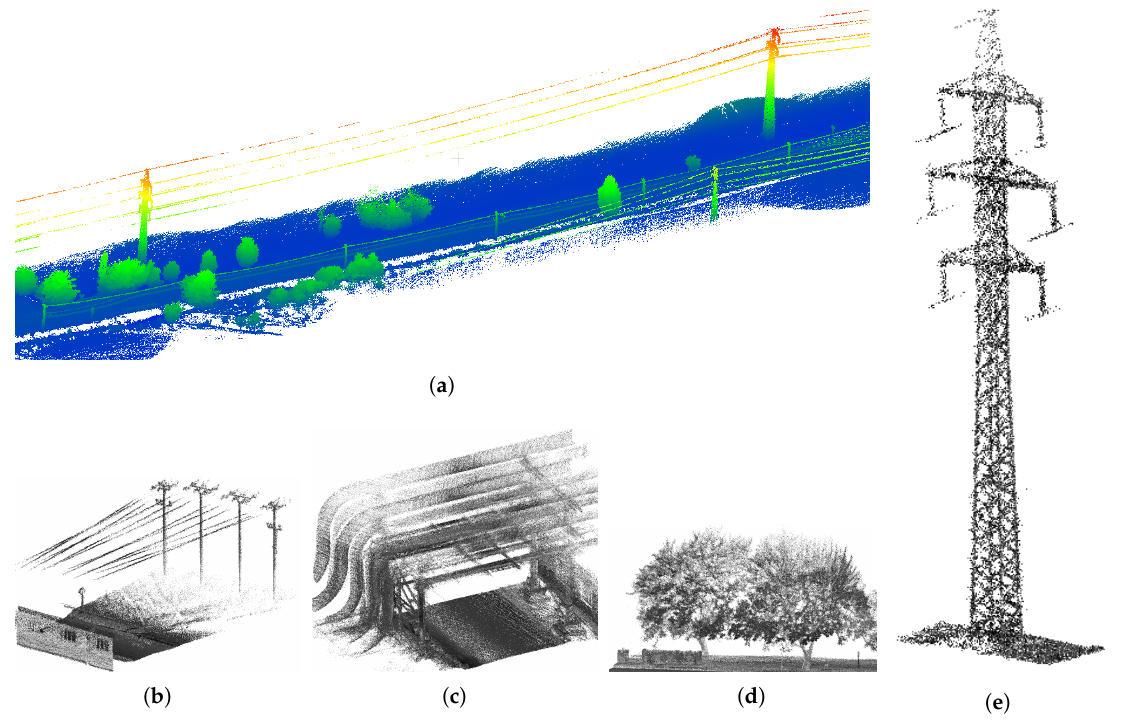
Figure 24. The example of 3D reconstruction of open field with high voltage electrical lines ( a ). The model is height-colored for better visibility. The estimation of positions and height of the lines ( b ), towers ( e ), etc. was the main goal of this mapping task. The other elements ( c , d ) in the scene are shown for demonstration of the reconstruction quality.